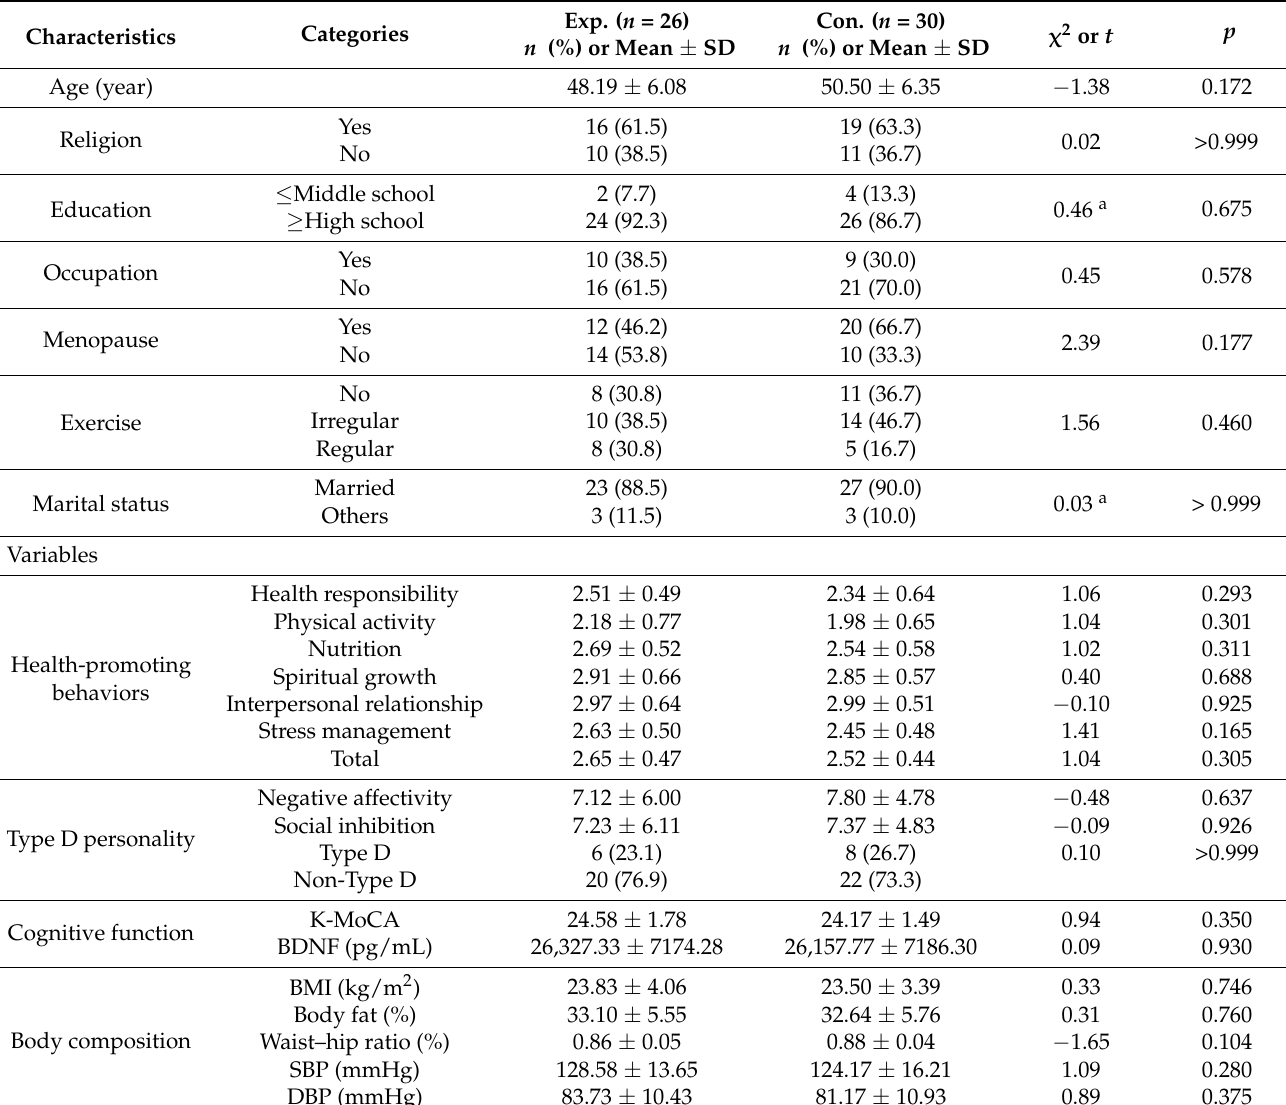
Table 2. Homogeneity test for participant characteristics and variables in the experimental and control groups ( n = 56).